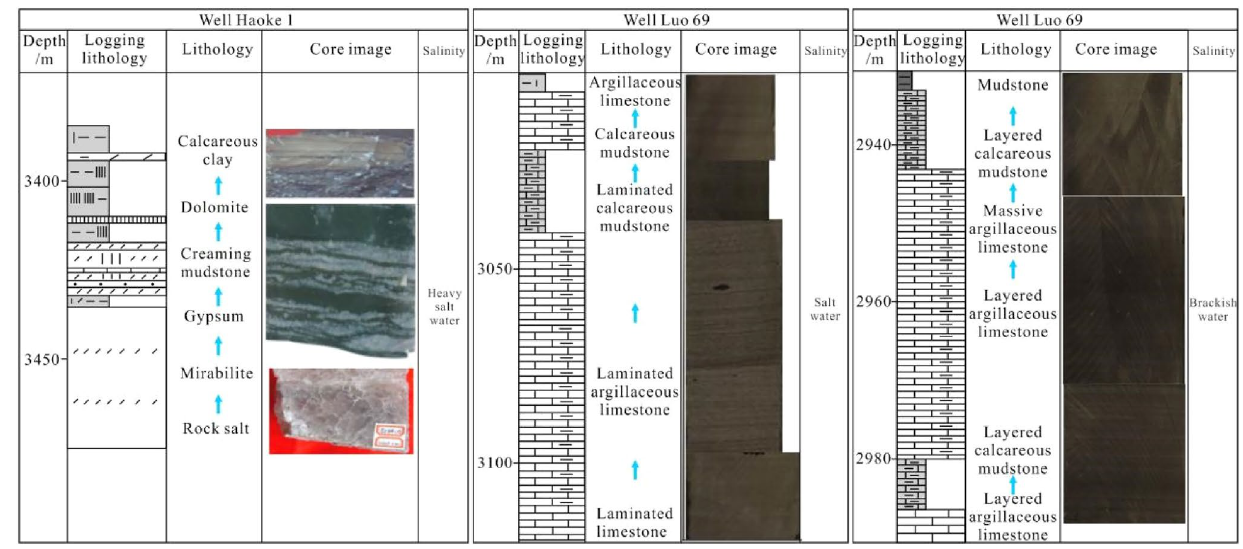
Fig. 4 sedimentary characteristics of different saline